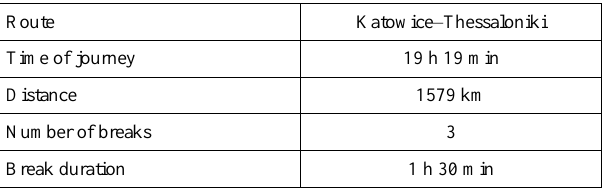
Table 7. Route details generated for Tesla Model 3 Long Range with the utilization of fastcharger [7] Route